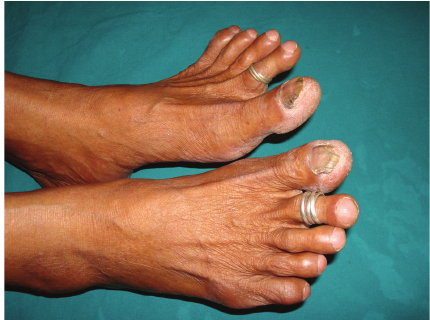
Figure 2: Absence of clubbing in digits of hands with no skin changes or edema at wrists while the clubbing is present in the toes.